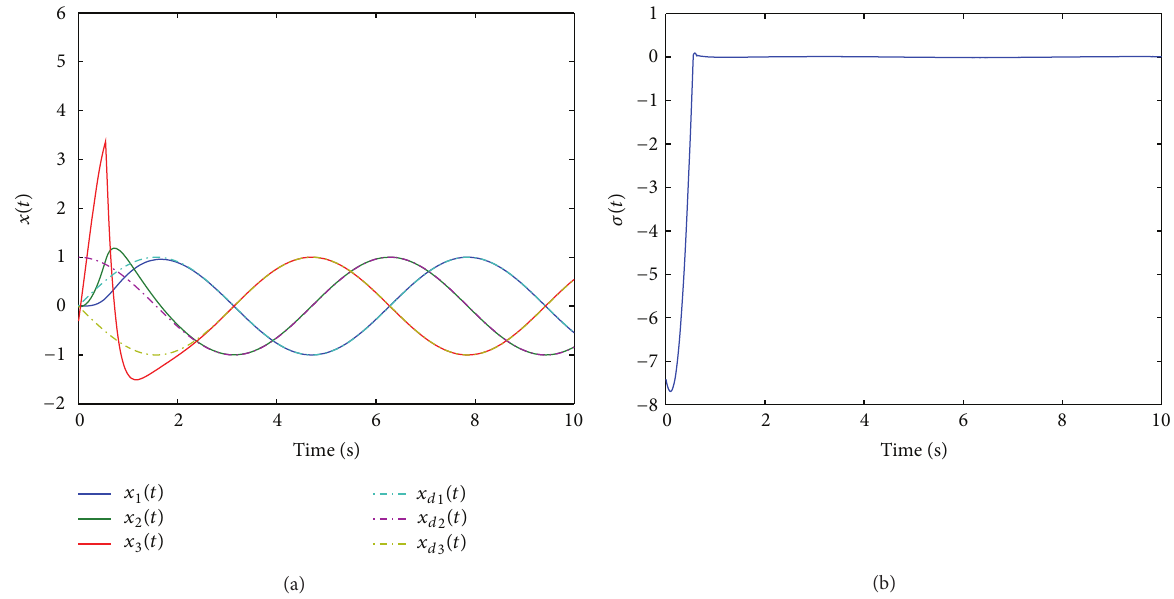
Figure 1: (a) States responses with TPASMC. (b) Sliding surface function with TPASMC.